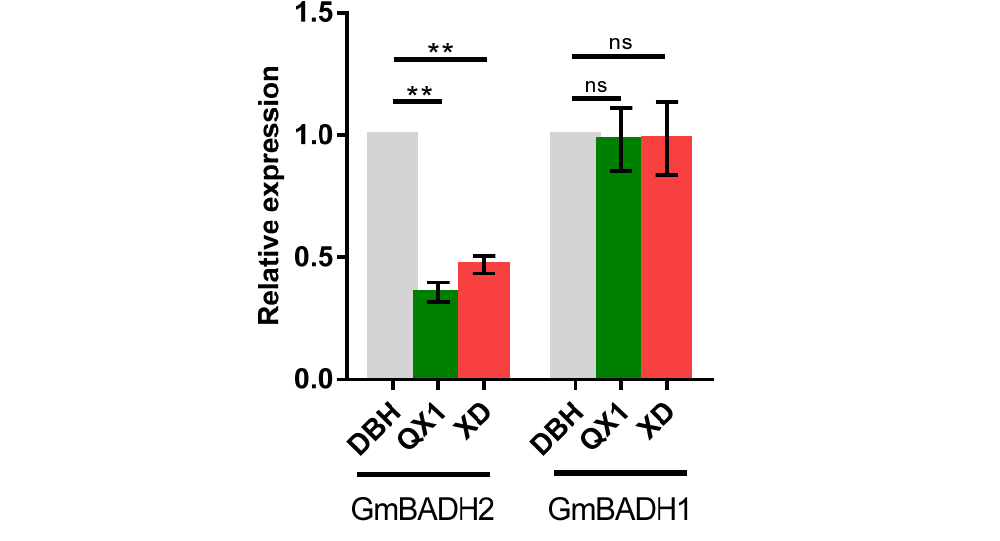
Figure 2. The GmBADH1 (Glyma06g19820) and GmBADH2 (Glyma05g01770) expression level in aromatic and non-aromatic soybean varieties. DBH: non-aromatic soybean variety. QX1 and XD: aromatic soybean varieties. Experiments were repeated using three independent biological replicates. Error bars: standard deviation. Significance was assessed by comparing the expression of each gene in the aromatic varieties with the corresponding expression in DBH; **, p < 0.01; ns, non-significant.